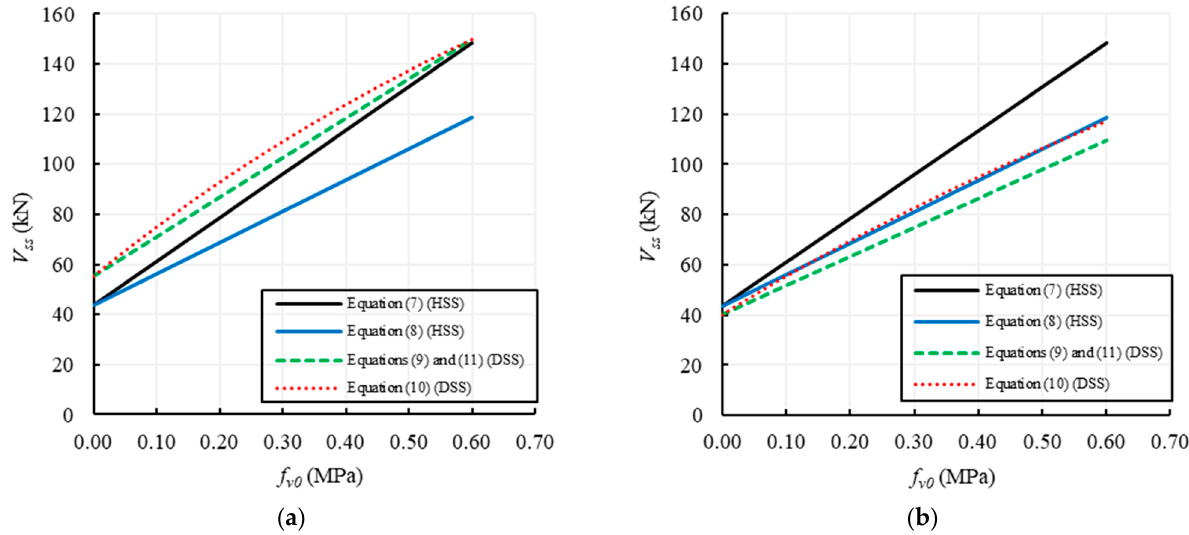
Figure 7. Sensitivity analysis for the shear capacity in regular masonry in function of f v0 , for µ = 0.58 and: ( a ) h b /b b = 0.5; ( b ) h b /b b = 1.